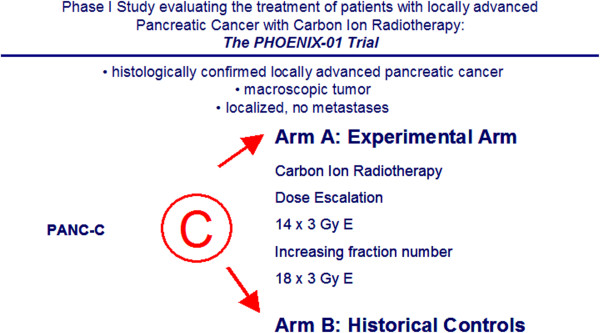
PHOENIX-01-Trial scheme.